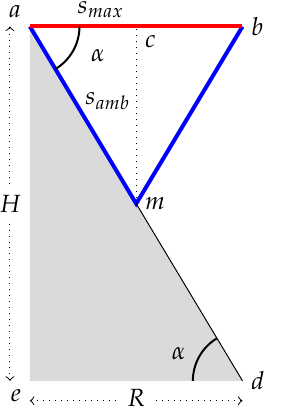
Figure A1. Cones and edges in projected